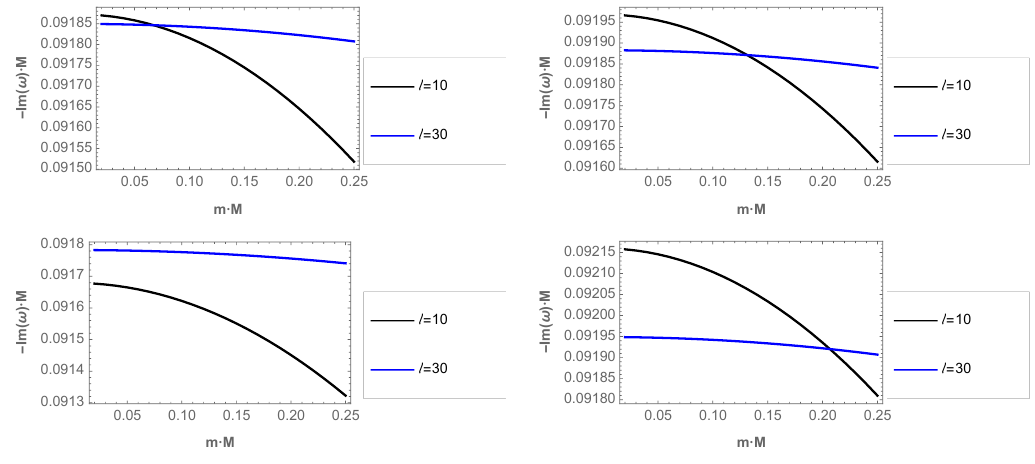
Figure 9 . Top panel for the behaviour of Im ( ω ) M of the photon sphere modes, left panels for the dominant mode n PS = 0 , and right panels for the first overtone n PS = 1 , as a function of mM for ‘ = 10 , 30 , with Λ M 2 = 0 . 01 , qQ = 0 . 01 (top panels), and qQ = 0 . 05 (bottom panel). Here, the WKB method gives via eq. (3.18) µ c M ≈ 0 . 109 , for qQ = 0 . 01 , and µ c M ≈ 0 . 110 , for qQ = 0 . 05 .